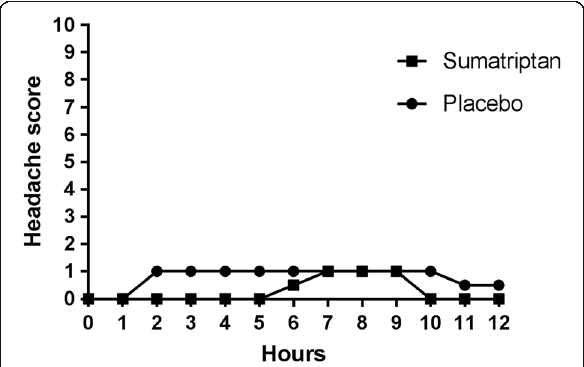
Fig. 1 Headache score 0-12 h after cilostazol. Median headache score 0-12 h after cilostazol. Median headache score was 1 on both days and thus we found no difference between the two treatment days